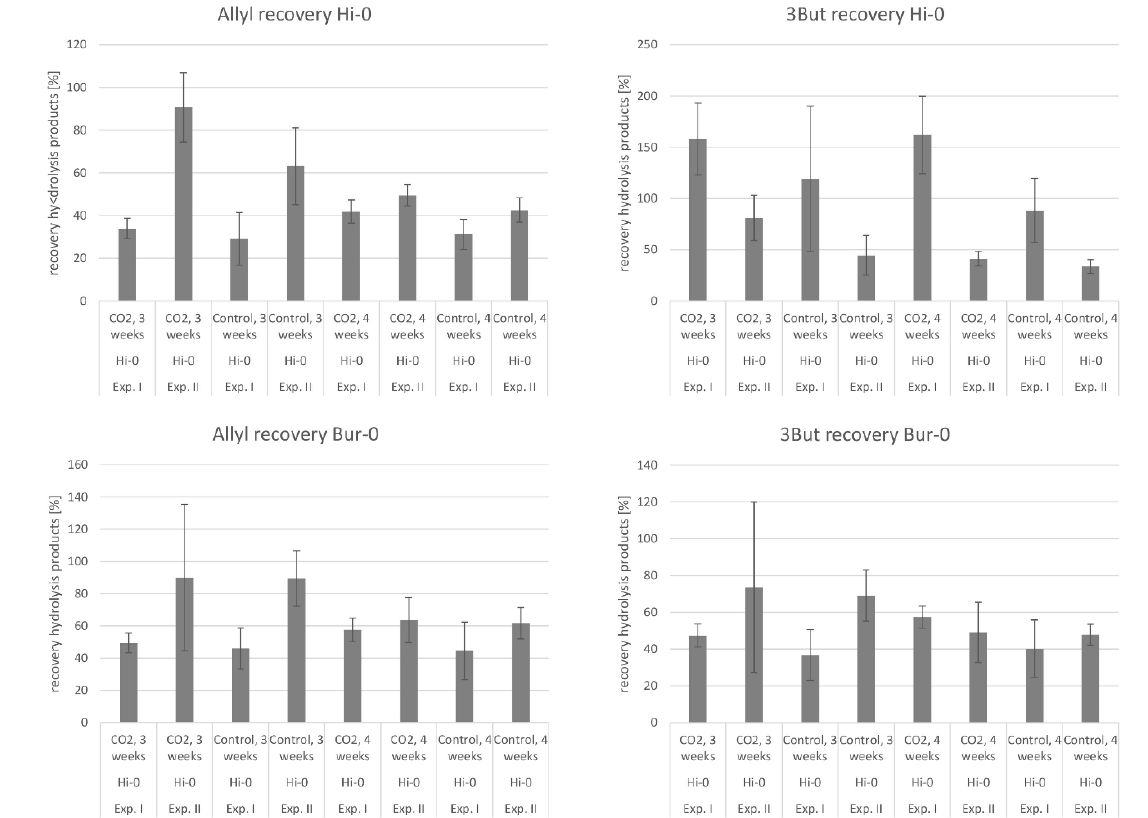
Fig. S4: Recovery of total allyl (Allyl) and 3-butenyl (3But) glucosinolate (GLS) hydrolysis products relative to the amount of the respective GLS values. Averages and standard deviations of biological replicates (n = 4-5) are shown for two experimental replications (I and II) separately.